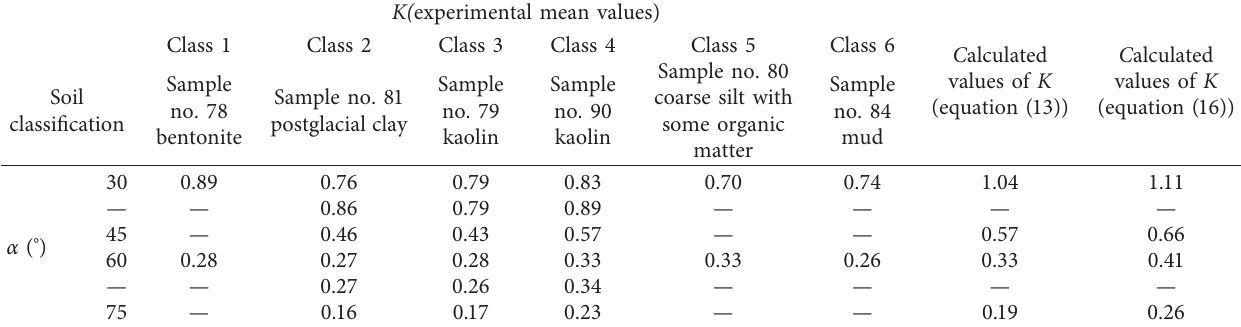
Table 1: Comparison of calculated and experimental values of K .